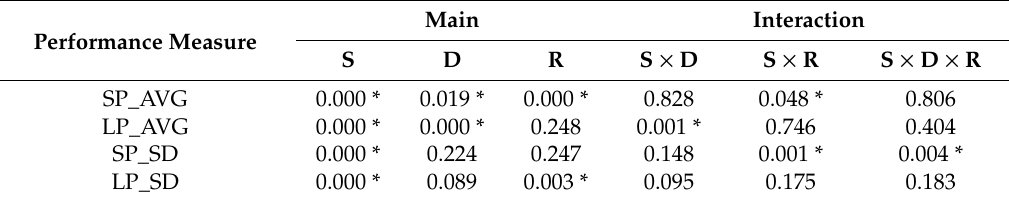
Table 1. Results of repeated measures ANOVA in curves for all of driving performance measures [17]. D: curve direction; R: radius; S: drivers’